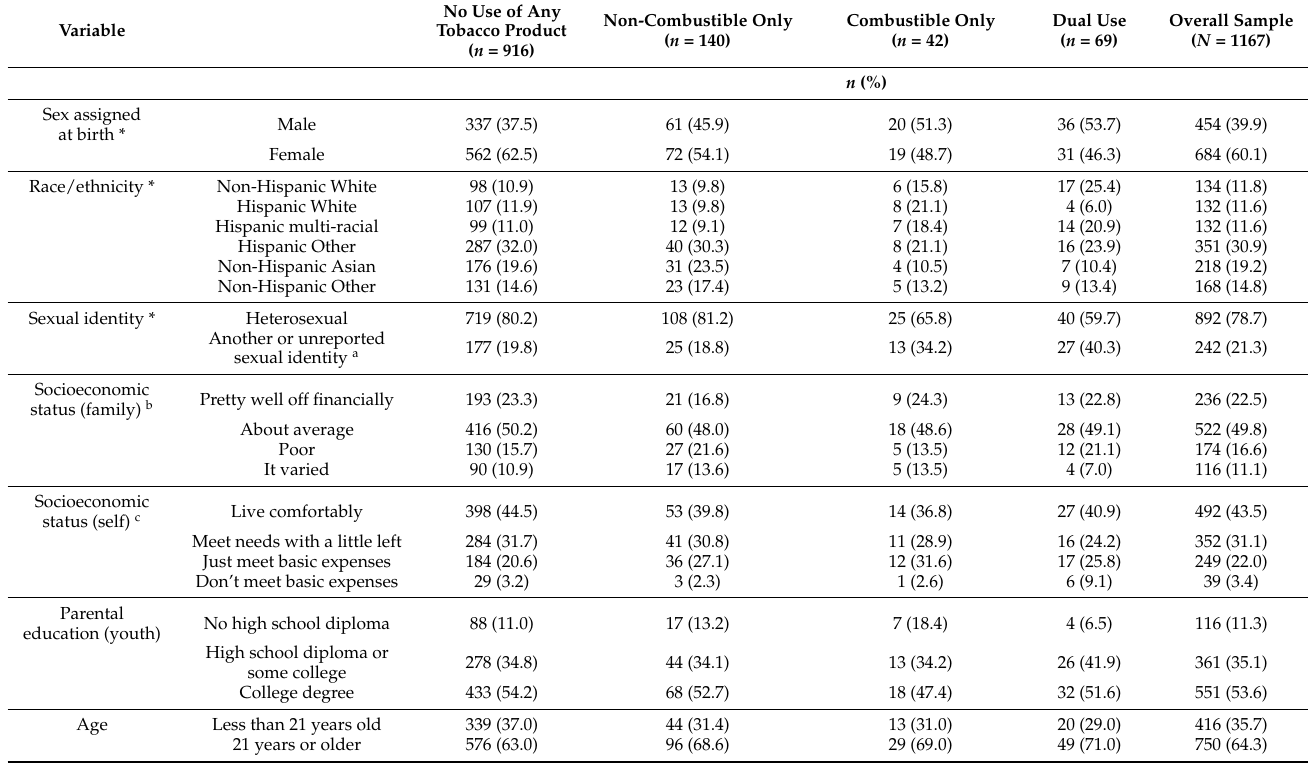
Table 1. Participant characteristics ( N = 1167) by past 30-day tobacco product use